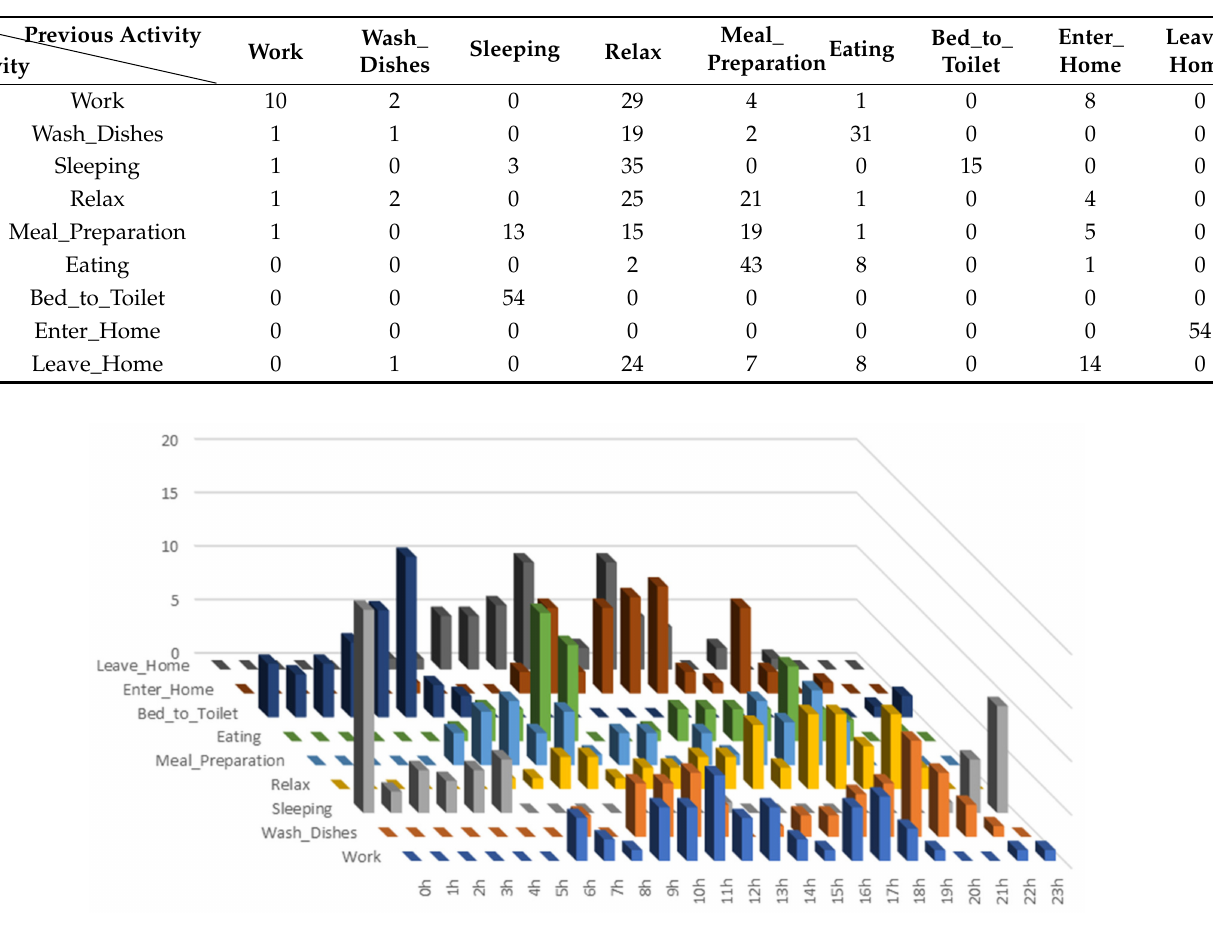
Figure 1. Number of current activity instances in terms of begin time-stamp